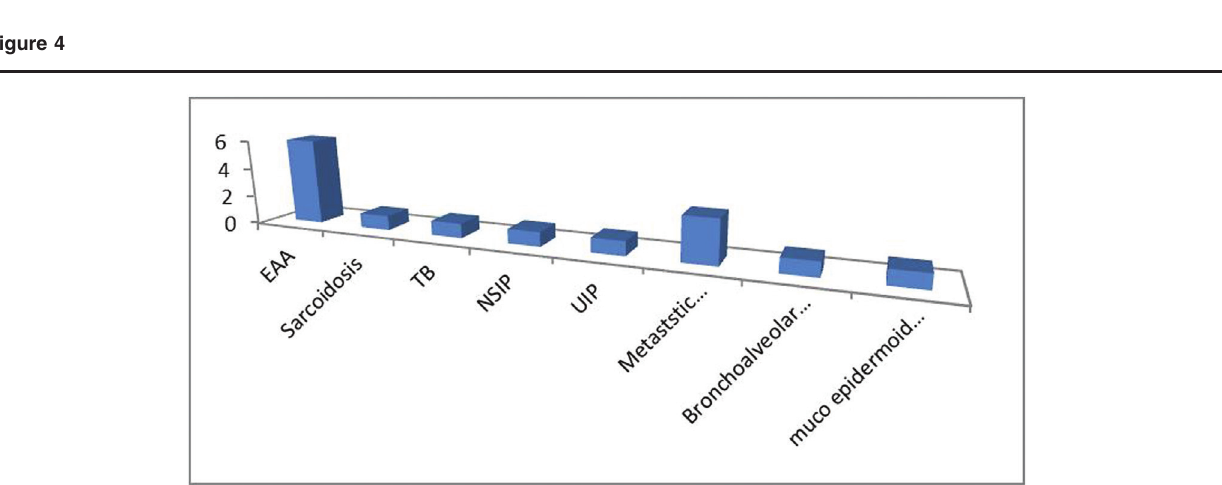
High-resolution computed tomography chest showed diffuse bilateral diffuse nodular lung infiltrations.